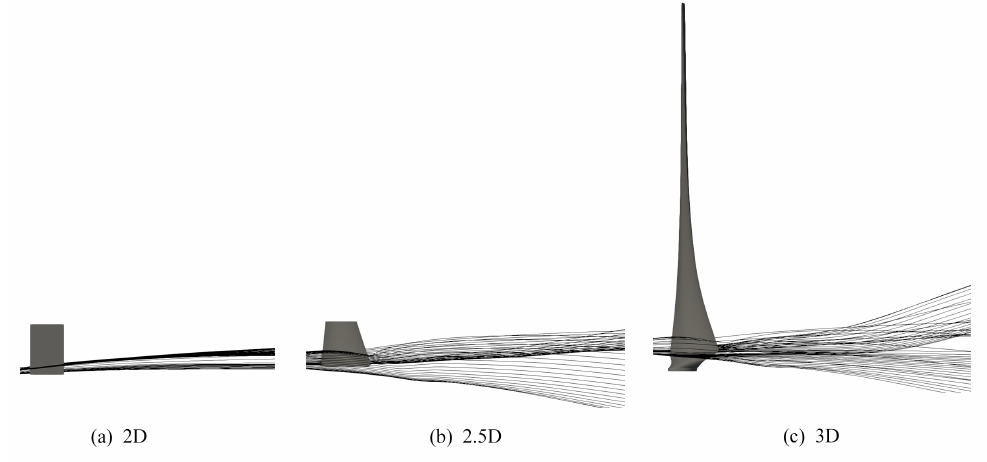
Figure 9. HAWT-S826: Illustration of the top view of flow streamlines for 2D, 2.5D and 3D geometric approximations simulated for the inner section of the turbine blade. The flow patterns indicate strong two-dimensional flow at the inner